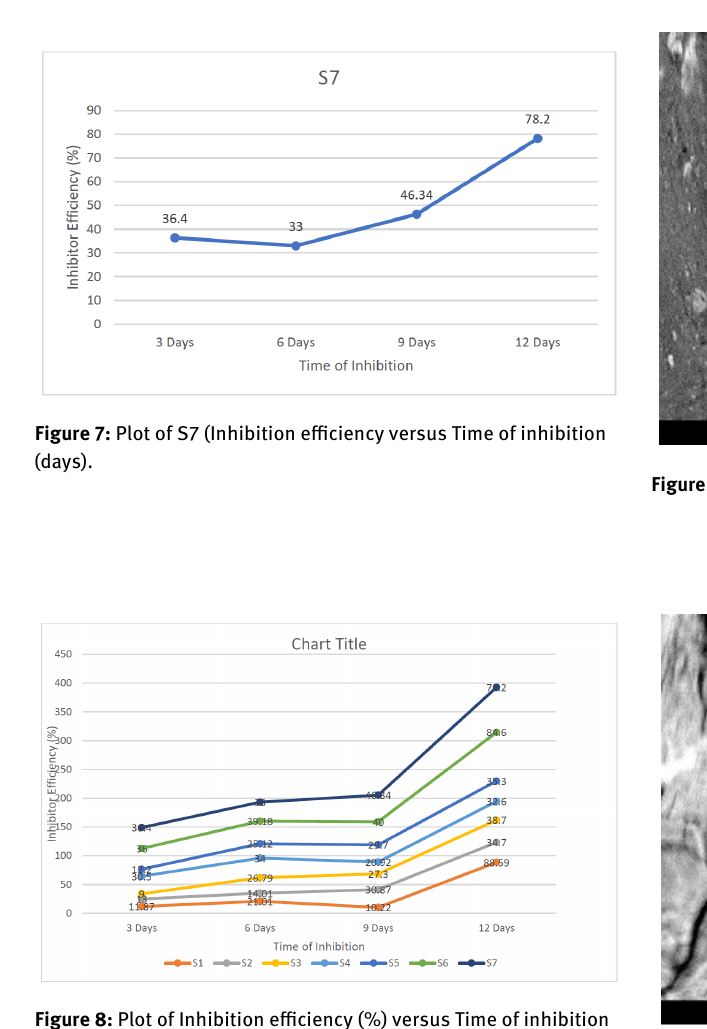
Figure 11: SEM result of the mild steel with the highest